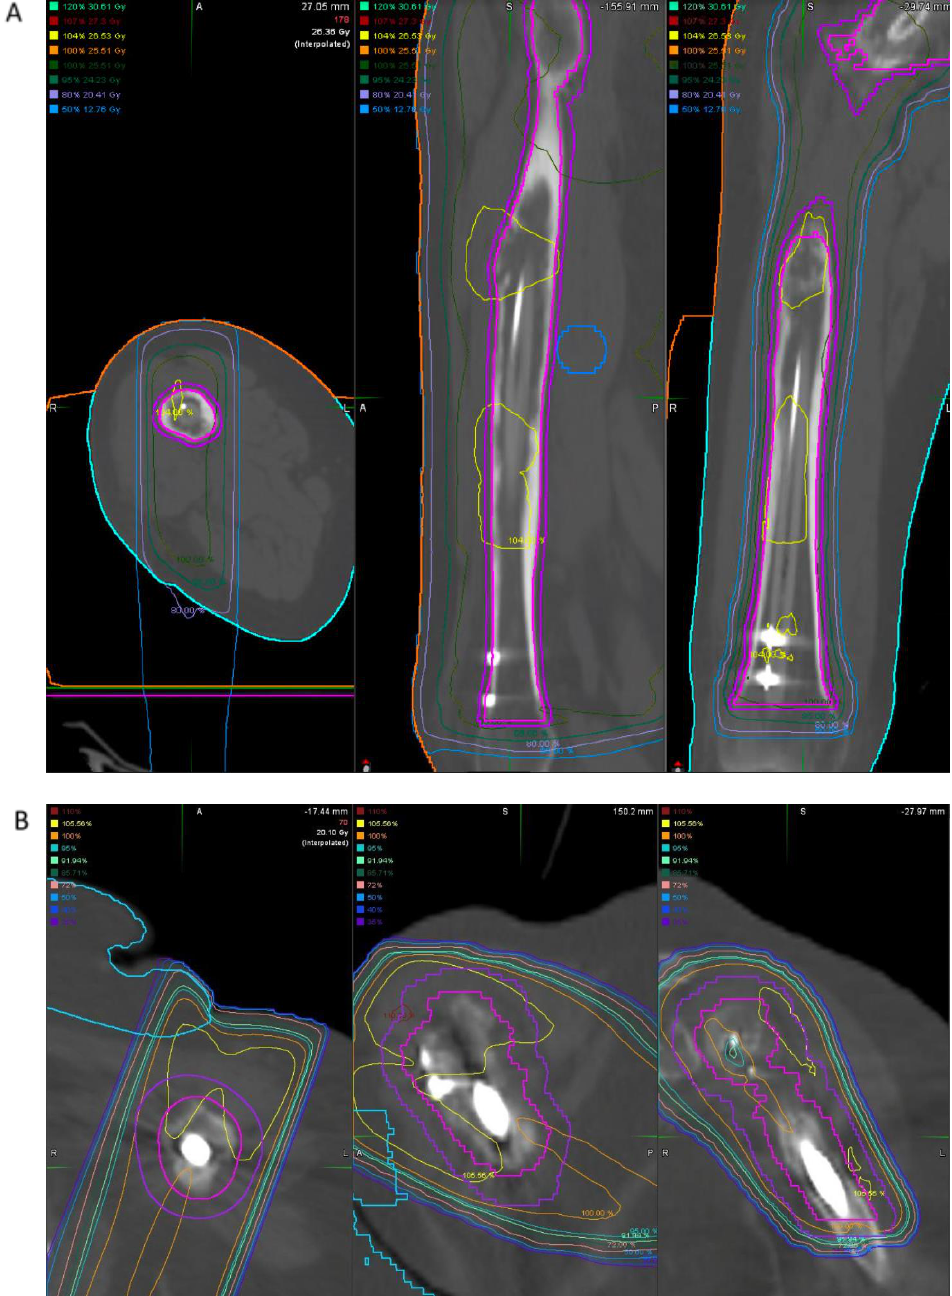
Figure 1. ( A ) Radiation therapy plan for a patient with impending pathologic fracture of the femur status post-intramedullary fixation with carbon fiber nail. Note is made of the minimal artifact from the intramedullary nail and relatively small amount of artifact from the metallic interlock screws. ( B ) Radiation therapy plan for a patient with impending pathologic fracture of the humerus sta- tus post-intramedullary fixation with titanium nail. Note the increased artifact caused by the in- tramedullary nail and interlock screws leading to increased target